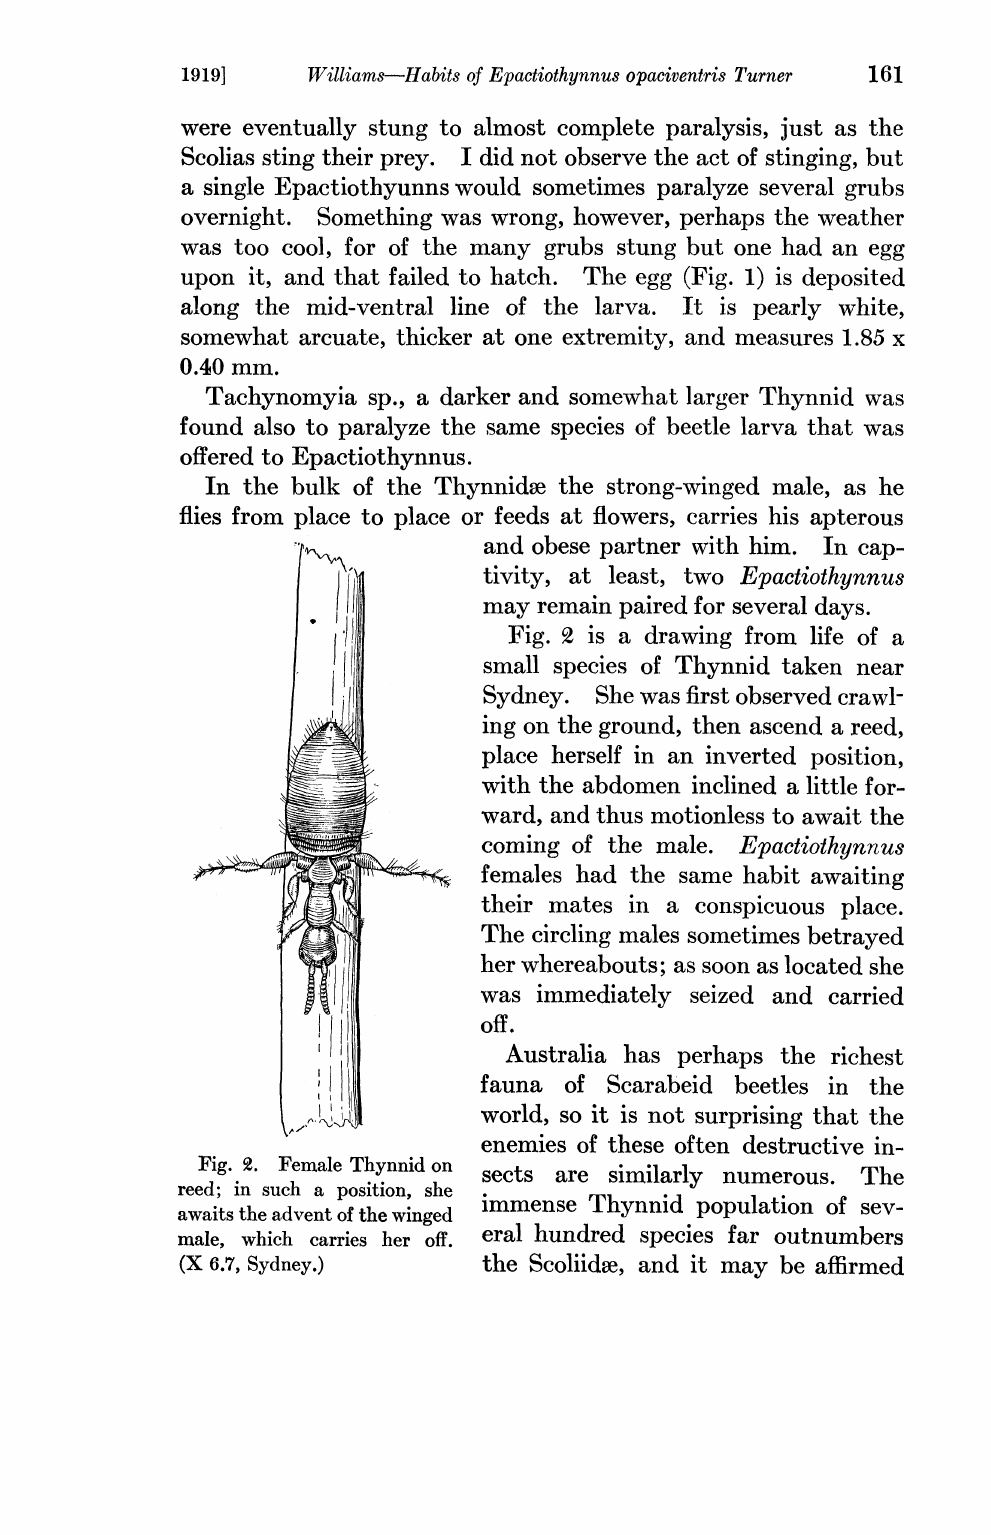
Fig. is a drawing from life of a small species of Thynnid taken near Sydney. She was first observed crawl- ing on the ground, then ascend a reed, place herself in an inverted position, with the abdomen inclined a little for- ward, and thus motionless to await the coming of the male. Epactiothynnus females had the same habit awaiting their mates in a conspicuous place. The circling males sometimes betrayed her whereabouts; as soon as located she was immediately seized and carried off. Australia has perhaps the richest fauna of Scarabeid beetles in the . world, so it is not surprising that the enemies of these often destructive in- Female Thynnid on Fig. sects are similarly numerous. The reed; in such a position, she immense Thynnid population of sev- awaits the advent of the winged eral hundred species far outnumbers male, which carries her off. the Scoliide, and it may be (X 6.7, Sydney.)